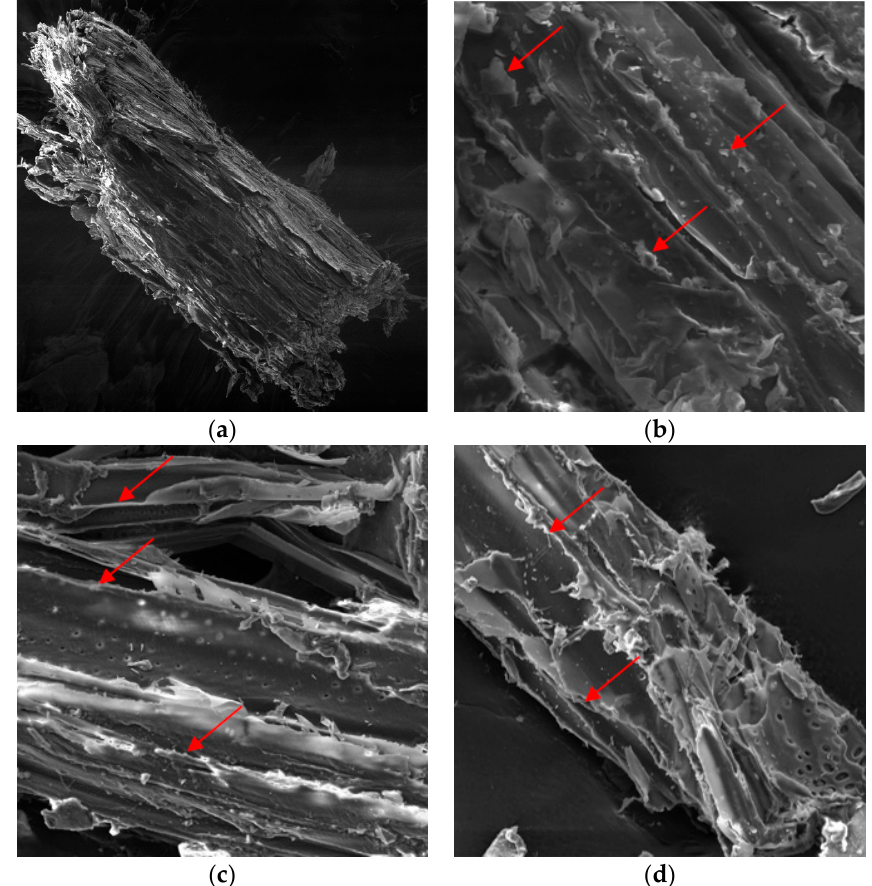
Figure 6. SEM micrographs of the hemp hurd samples: ( a ) original RHH sample (magnified 500 times); ( b ) RHH—original sample (magnified 4000 times); ( c ) NHH—chemically treated sample in NaOH (magnified 1500 times); ( d ) UHH—ultrasound treated sample (magnified 1500 times).